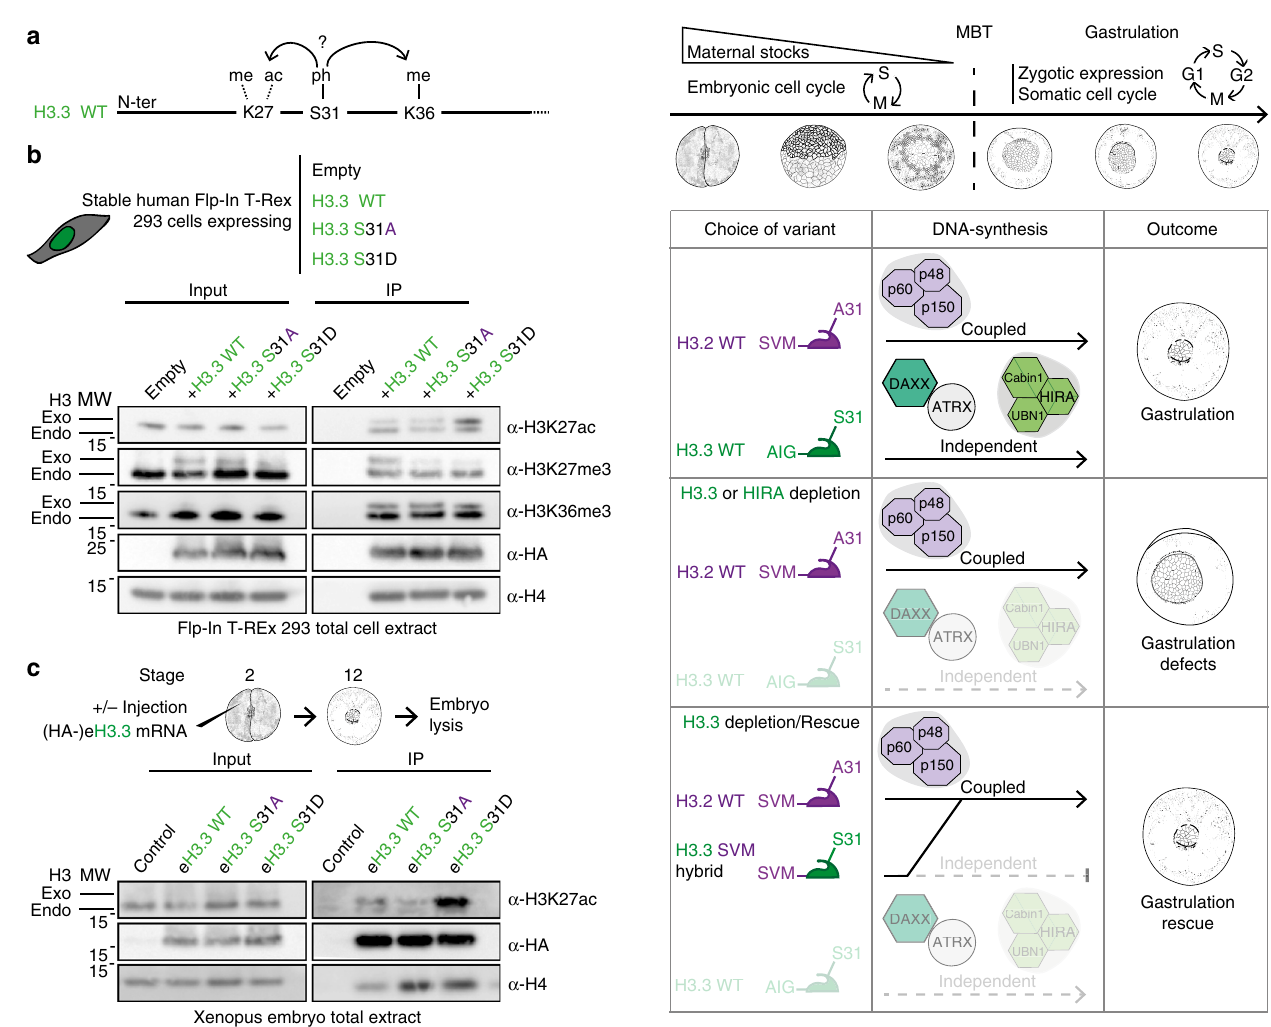
Fig. 7 H3.3 S31D promotes H3K27ac and reduces H3K27me3 in- cis . a Scheme of potential crosstalk of H3.3 S31ph with neighboring PTMs. H3.3 S31 is located between H3.3K27 and H3.3K36, which can both be modi fi ed. b PTM crosstalk analyzed in H3.3-transfected Flp-In T-Rex 293 cell lines. Immunoprecipitations of H3.3 mutants enabled to enrich for the exogenous form. Presence of PTMs is analyzed by western blotting with indicated antibodies. α -HA antibody is used to detect eH3.3. H4 is used as an internal control. Primary antibodies indicated on the right. Molecular weight (MW) markers in kDa indicated on the left. Exo: exogenous H3.3, endo: endogenous H3 and H3.3. c PTM crosstalk in Xenopus embryos. Immunoprecipitations of eH3.3 mutants and controls are performed at stage 12 after their injection at the 2-cell stage and are analyzed by western blotting with indicated antibodies. α -HA antibody is used to detect eH3.3. H4 is used as an internal control. Primary antibodies indicated on the right. Molecular weight (MW) markers in kDa indicated on the left. Exo: exogenous H3.3, endo: endogenous H3 and H3.3. Source data are provided as a Source Data fi le.